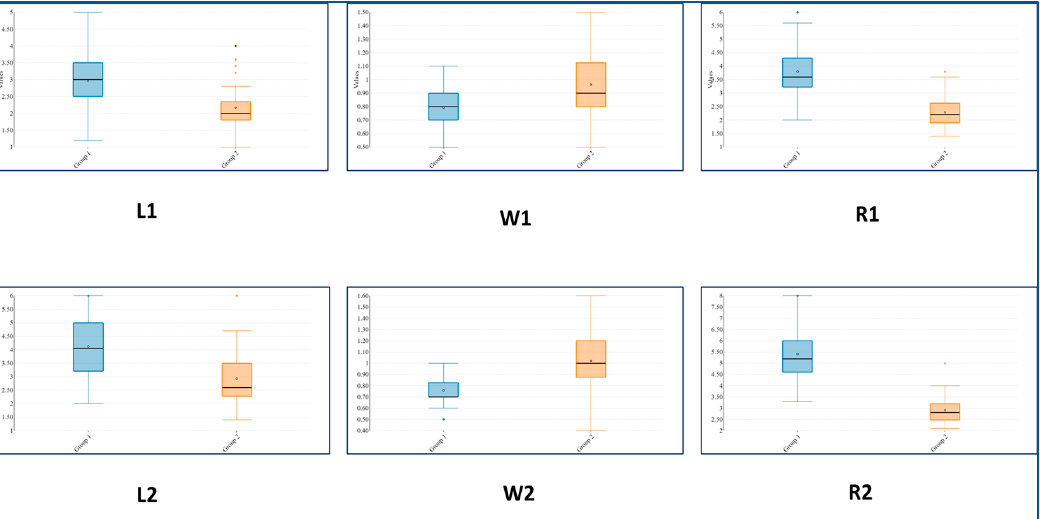
Figure 3. Boxplot for the most discriminant morphological characters. L1, W1, R1: length, width, and ratio of length/width of the uppermost leaf pair; L2, W2, R2: the same traits for the second leaf pair. Table 1. Comparison of the key morphological characters of S. scardica and the new species, S. elica . Characters